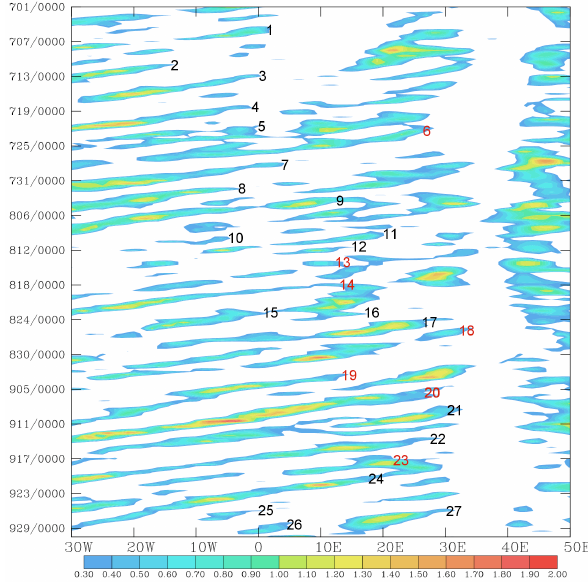
Figure 19. Hovmoeller space-time diagram of 700 hPa curvature vorticity averaged between Fig. 19. Hovmoeller space-time diagram of 700hPa curvature vor- 5°N and 15°N based on NCEP analysis. The numbers refer to synoptic systems that meet the ticity averaged between 5 ◦ N and 15 ◦ N based on NCEP analysis. tracking criterion used by Berry et al. (2007). Those in red became tropical cyclones in the The numbers refer to synoptic systems that meet the tracking cri- Atlantic basin. These were Chris (6), Ernesto (13), Debby (14), Florence (18), Gordon (19), terion used by Berry et al. (2007). Those in red became tropical Helene (20), Isaac (23). On the vertical axis time is expressed as month-day/hour. cyclones in the Atlantic basin. These were Chris (6), Ernesto (13),